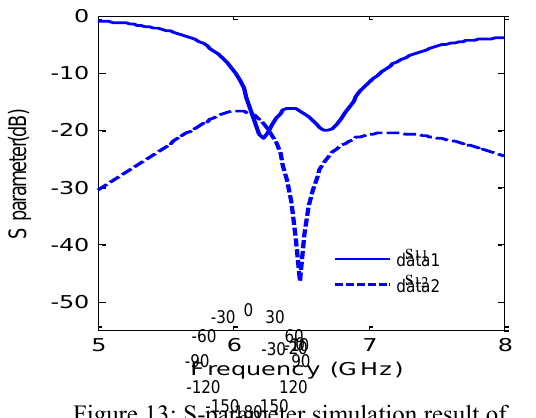
Figure 13: S-parameter simulation result of SDRA antenna array with Bucky parasitic element.